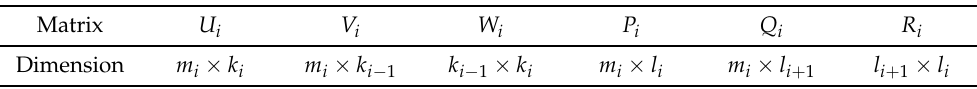
Table 1. Dimensions of the generators of the SSS matrix shown in Equation (4), k i and l i are column dimensions of U i and P i ,